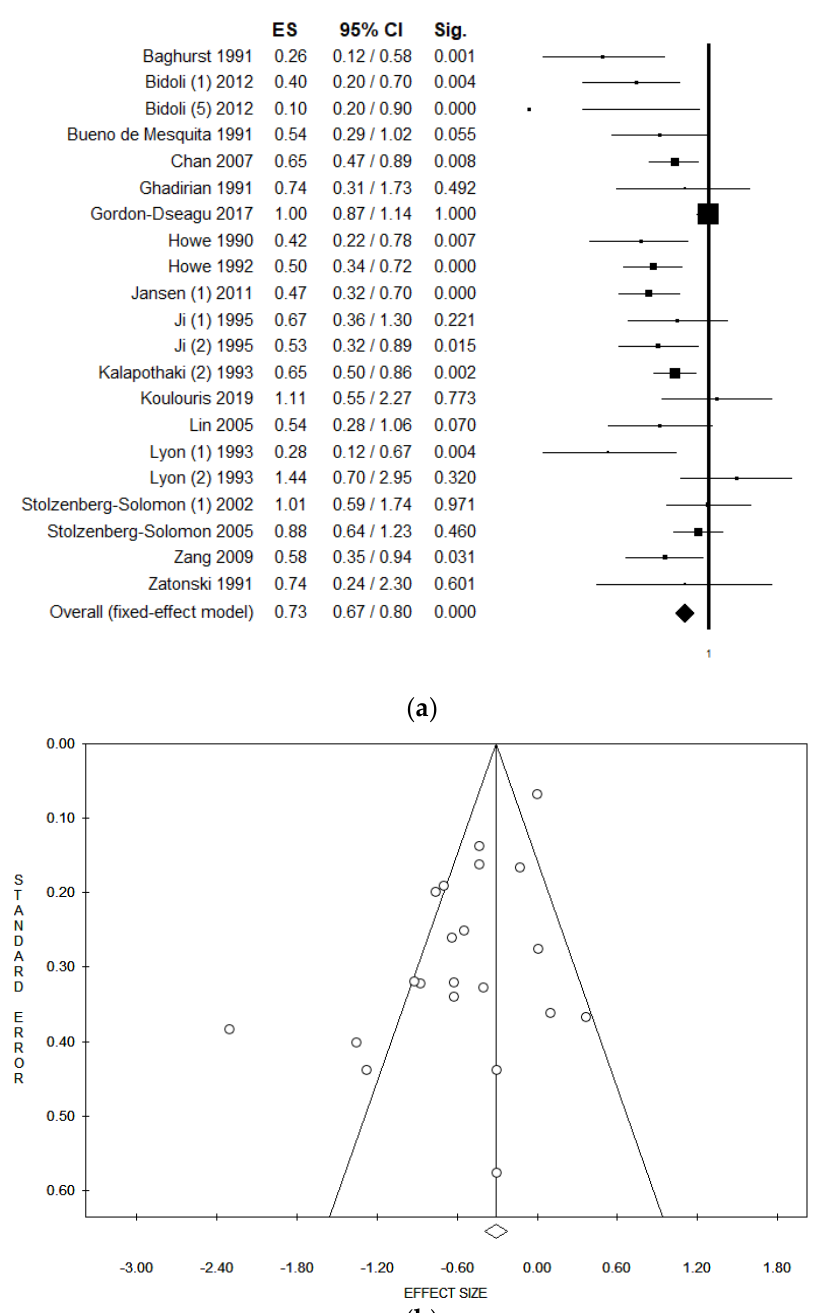
Figure 2. ( a ) Forest plot and ( b ) Funnel plot of the meta-analysis comparing dietary fiber intake (lower v. higher intake) and risk of pancreatic cancer (fixed effect model).